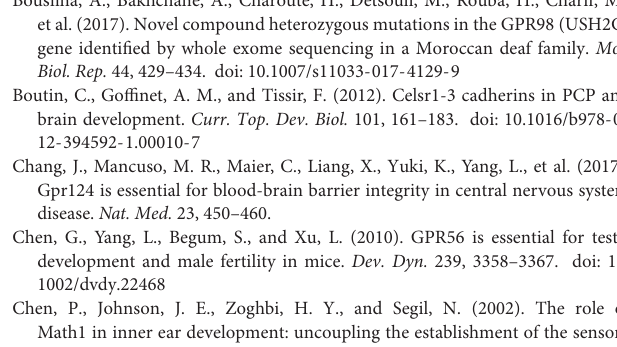
Supplementary Figure 1 | Expression of Gpr125- β -Gal in spiral ganglion neurons in E15.5 Gpr125 lacZ / + mice. (A,A’) Representative low magnification images of cochlear sections of E15.5 Gpr125 lacZ / + mice immunostained for Gpr125- β -Gal (green) and Tuj1 (red). Gpr125- β -Gal was detected in Tuj1 + spiral ganglion neurons (SGN) (dashed line), albeit at lower level than the cochlear duct. (B–D) High-magnification images of SGNs from each turn shown in panel (A) . There were few β -Gal + , Tuj1 + cells in the apical turn and many β -Gal + , Tuj1 + cells (arrowheads) in the middle and basal turns, respectively. Supplementary Figure 2 | Gpr125 is dispensable for cochlear development. (A) No significant differences were seen among the lengths of wild-type, Gpr125 + / lacZ and Gpr125 lacZ / lacZ cochleae. (B–J”) Whole mount preparation of wild-type and Gpr125 lacZ / lacZ at E15.5, E18.5, P0, P4 and P30. Immunostaining for Myosin7a, F-actin and Sox2, demonstrated no loss of hair cells, hair bundles, or